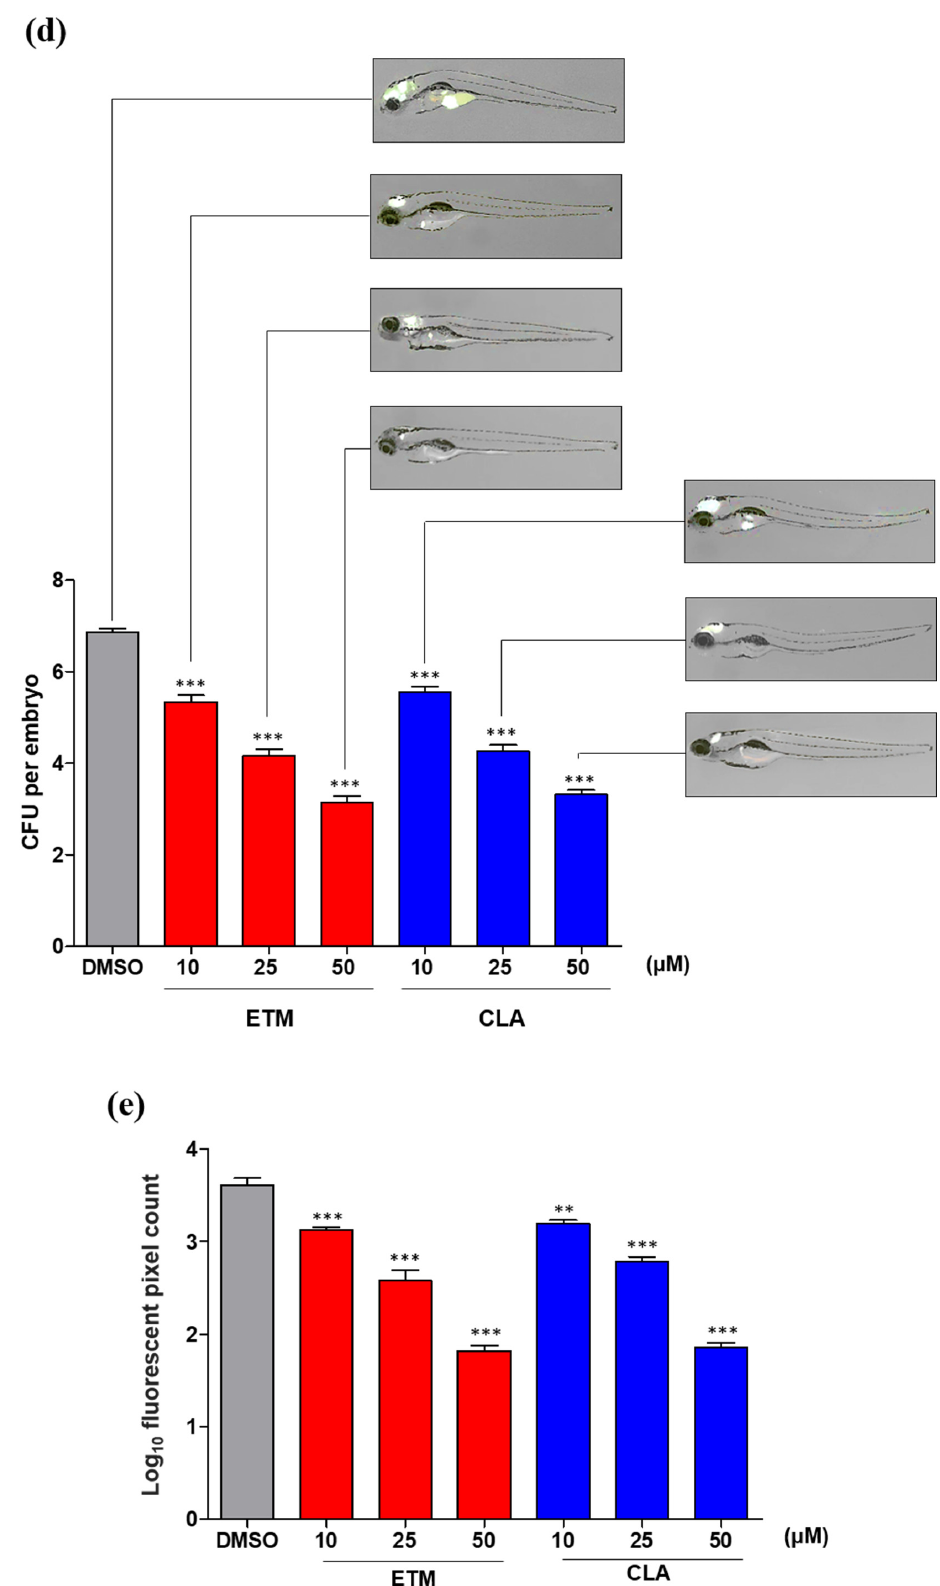
Figure 5. In vivo e ffi cacy of etamycin in the zebrafish (ZF) model of infection. ( a ) Various concentrations of the etamycin (12.5, 25, 50, and 100 µ M) were treated to the zebrafish without M. abscessus infection and the maximum tolerated dose of etamycin was measured. ( b ) The survival curve was plotted